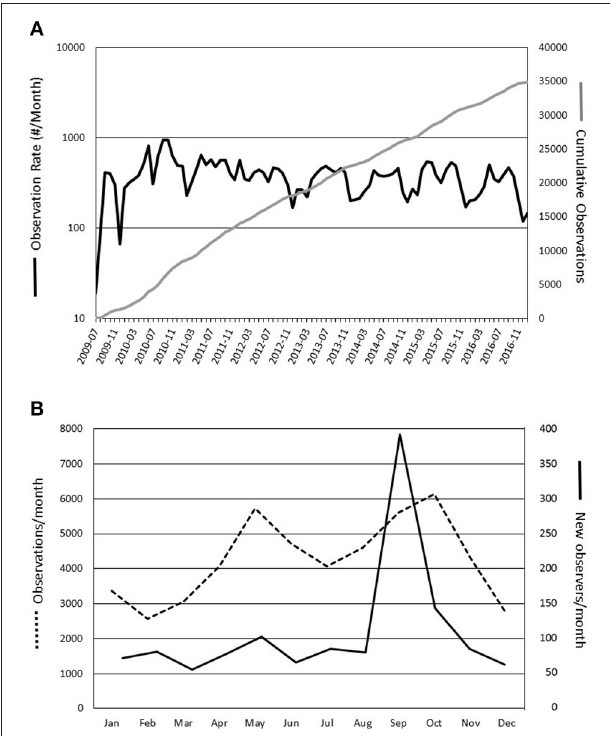
FIGURE 3 | (A) Monthly participation rate (dark line) and cumulative participation (gray line) for the California system between 9/2009 (initiation) and 1/2017 (present). (B) Rates of observation per month (dashed line) and new observers per month (black line) for the California system (9/2009–1/2017). Only observations since the start date of each state-system are shown; there were records entered in each system by observers who had made observations of wildlife prior to the beginning of the